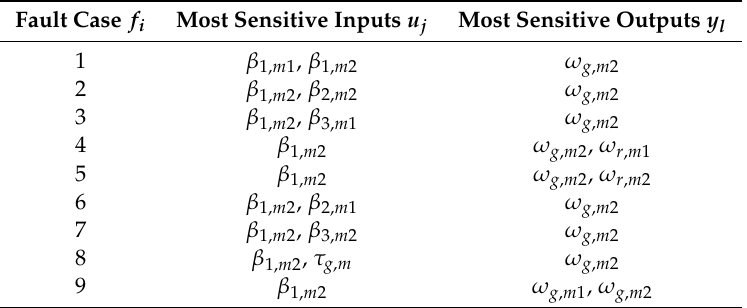
Table 3. The most sensitive measurements with respect to the considered fault scenario.